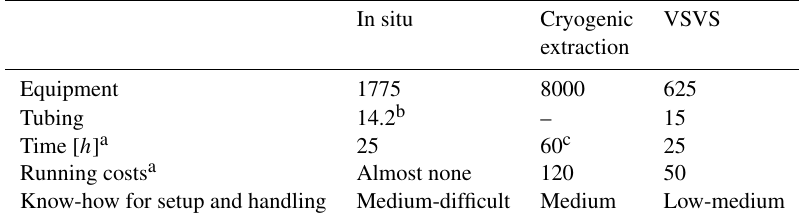
Table 2. Cost [EUR] and time [ h ] effort overview comparing in situ systems, cryogenic extraction and VSVS. a per 100 samples, b per installed soil depth in Kübert et al. (2020), c including six injections per sample on a CRDS. Data for the in situ and cryogenic extraction analysis derived from Kübert et al. (2020). The time effort includes the time needed for setup, and maintenance but not for data analysis. The costs of power and gas supply are not